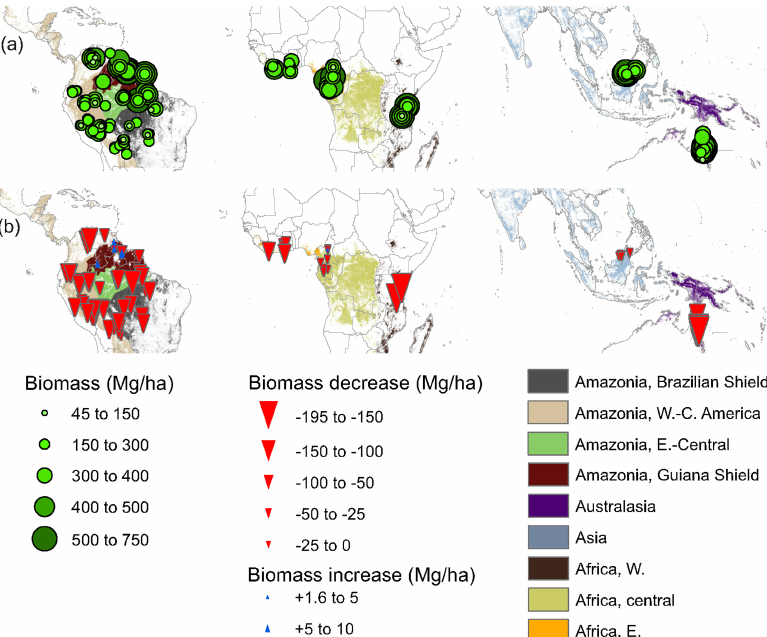
Fig. 1. Location of the pantropical permanent plots, including (a) biomass stocks (Mgha − 1 ) , and (b) change in biomass (Mgha − 1 ) due to inclusion of H in biomass estimates ( B ) (relative to exclusion of H ) for forests ( B H – B No − Ht . ) in Africa, Asia, Australia, and South America. Symbols indicate an increase (blue) or decrease (red) in biomass estimates after including H compared to our biomass model Eq. (1) that excludes H . See Supplement Table S1 for plot details. Biomass was estimated from the moist forest pantropical models (Table 1) based on tree diameter and wood density, and H (where applicable), with H estimated from Weibull region-specific tree H models (Eq. 5) based on the pantropical tree H – D database shown in Feldpausch et al. (2011). Coloured shading indicates forest cover and different regions used in Figs. 3 and